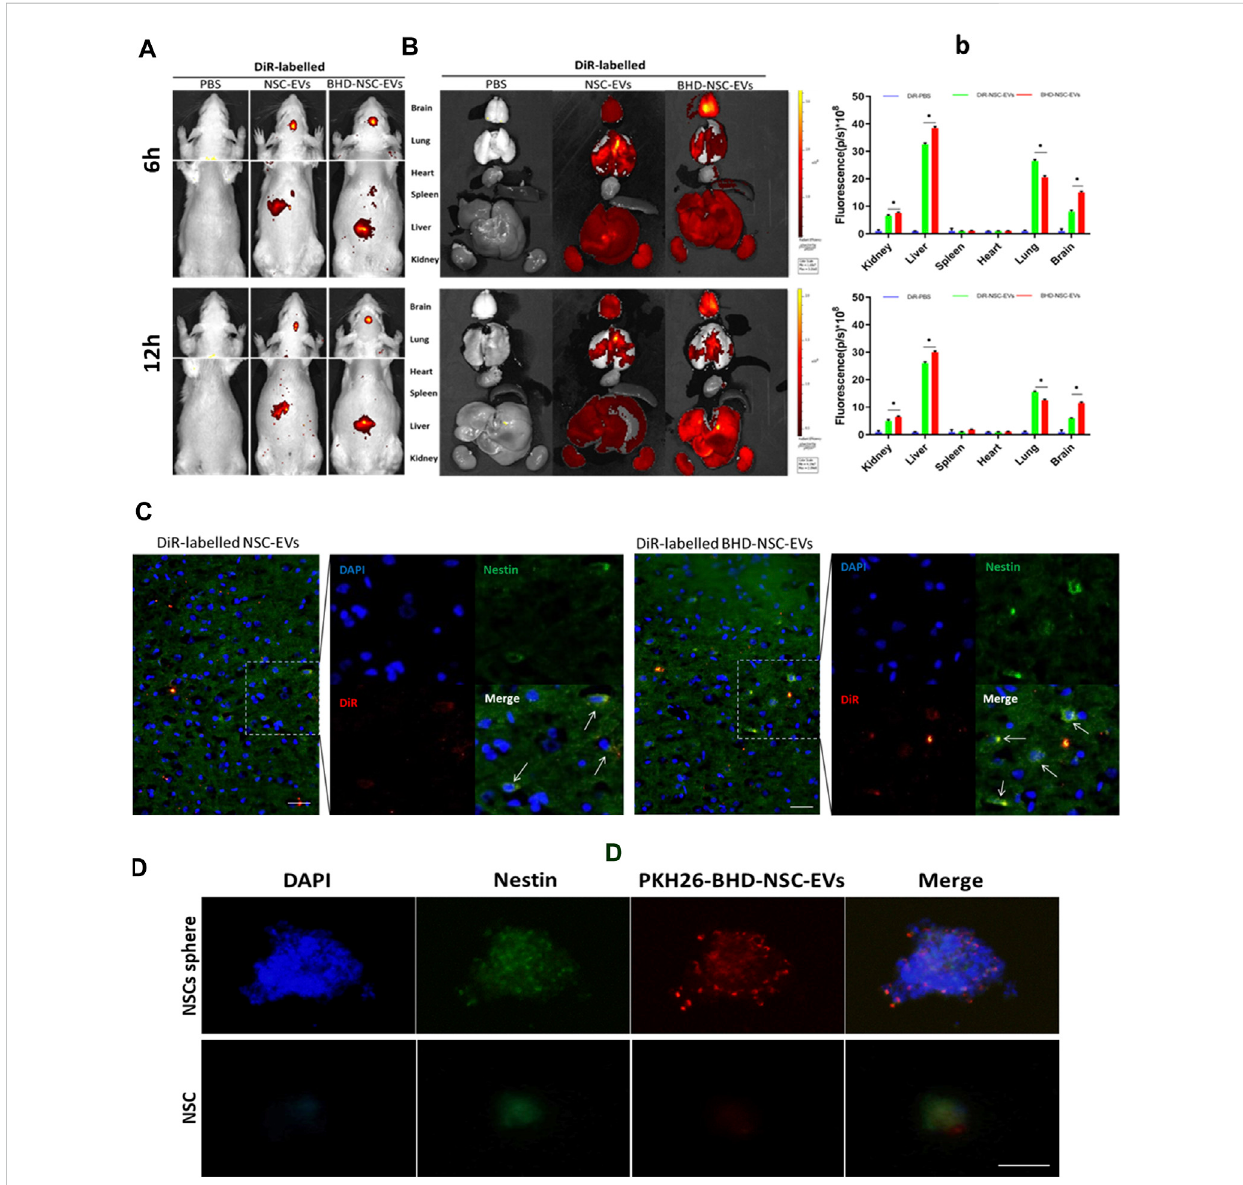
FIGURE 3 The biodistribution of BHD-NSC-EVs in vivo and in vitro . (A) Representative IVIS images showed the DiR-labeled NSC-EVs and BHD-NSC-EVs were intravenously injected through caudal vein after 6 and 12 h and mainly accumulated in the heads of MCAO model rats using the Bruker Small Animal Optical Imaging System. (B-b) Representative IVIS images of six different organs including the brain, lung, heart, spleen, liver, and kidney harvested after 6 and 12 h following caudal vein injection of DiR-labeled NSC-EVs and DiR-labeled BHD-NSC-EVs, respectively. Quanti fi cation of the fl uorescent intensity expressed as themeans± SEMs ( n =17/timepoint) demonstrated thebiodistribution ofBHD-NSC-EVs andNSC-EVs insix differentorgans. ( n = 5); ns, no signi fi cance; ** p < 0.01, BHD-NSC-EVs vs. NSC-EVs (C) Representative immuno fl uorescent images of brain sections revealed the DiR-labeled BHD-NSC-EVsandNSC-EVs (red)couldbetakenupbyendogenous NSCs(green/blue). (D) The uptakeofPKH26-labeledBHD-NSC-EVs(red)innestin + NSCs sphere or NSC (green) was visualized using confocal microscopy, the scale bar: 20 µm. All data are from three independent experiments and are presented as mean ± s.e.m, two-sided Student ’ s t -tests were used for comparisons (B) . IVIS, infrared video data imaging system; NSC-EVs, Neural Stem Cells Derived Extracellular Vesicles; BHD-NSC-EVs, Medicated Plasma of Buyang Huanwu Decoction-Preconditioned Neural Stem Cells Derived Extracellular